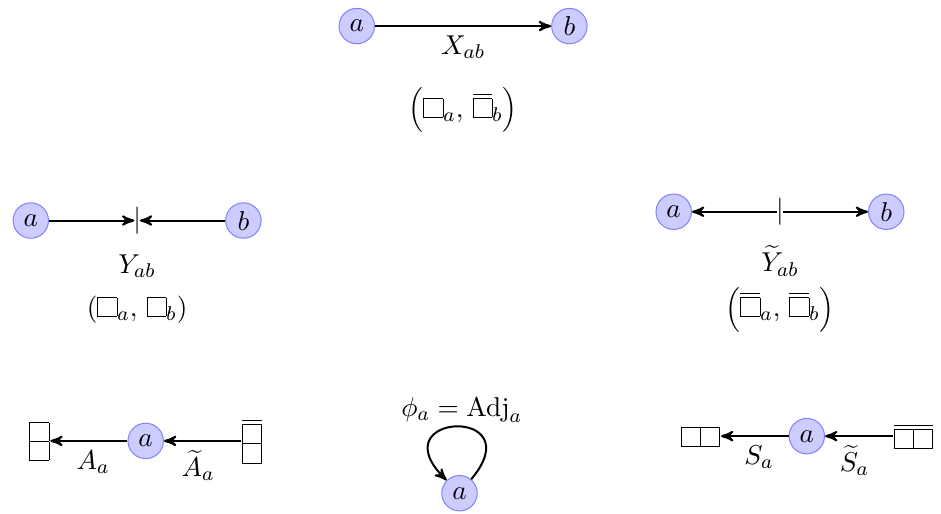
Figure 4. The various matter fields and their representations that we will use in quiver diagrams. We draw multiple arrows for multiple fields connecting the same pair of nodes. When nodes are both SO and/or USp groups, we drop the arrow and connect them with an edge, signaling the fact that representations are real. For tensor representations, when not specified if they are symmetric or antisymmetric, we simply denote them by T a